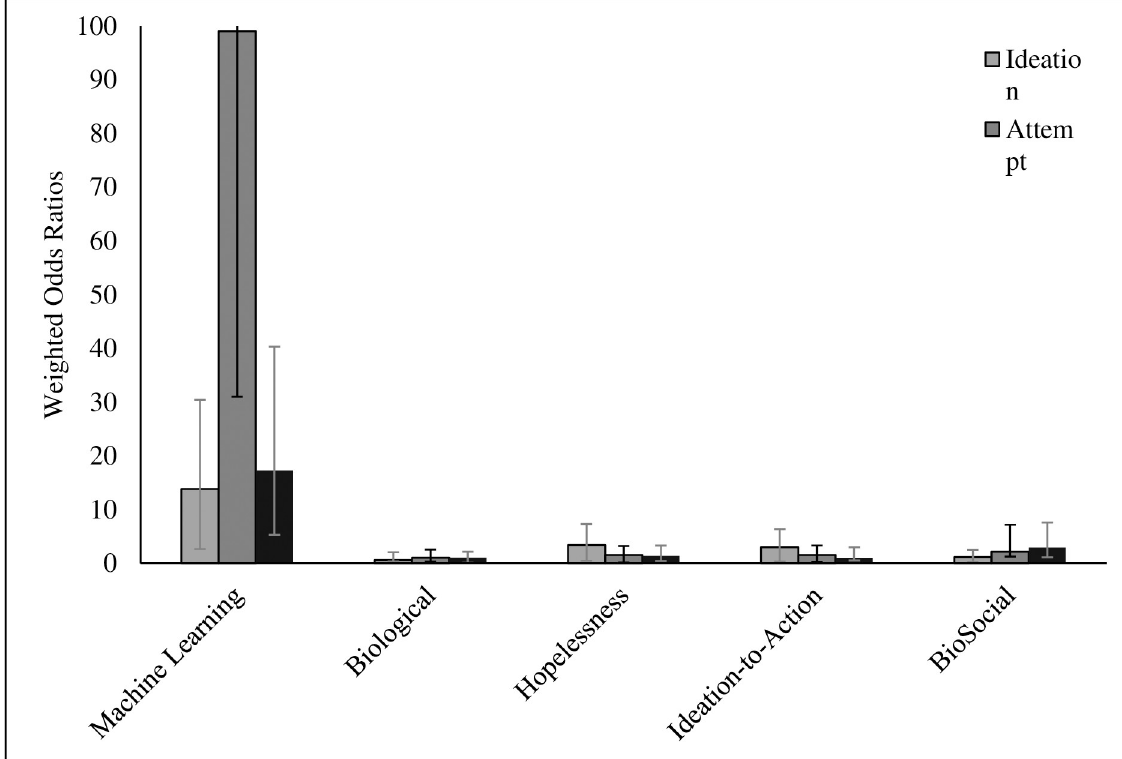
Fig 2. Prediction of overall, death, attempt, ideation outcomes by theoretical perspective and machine learning models.